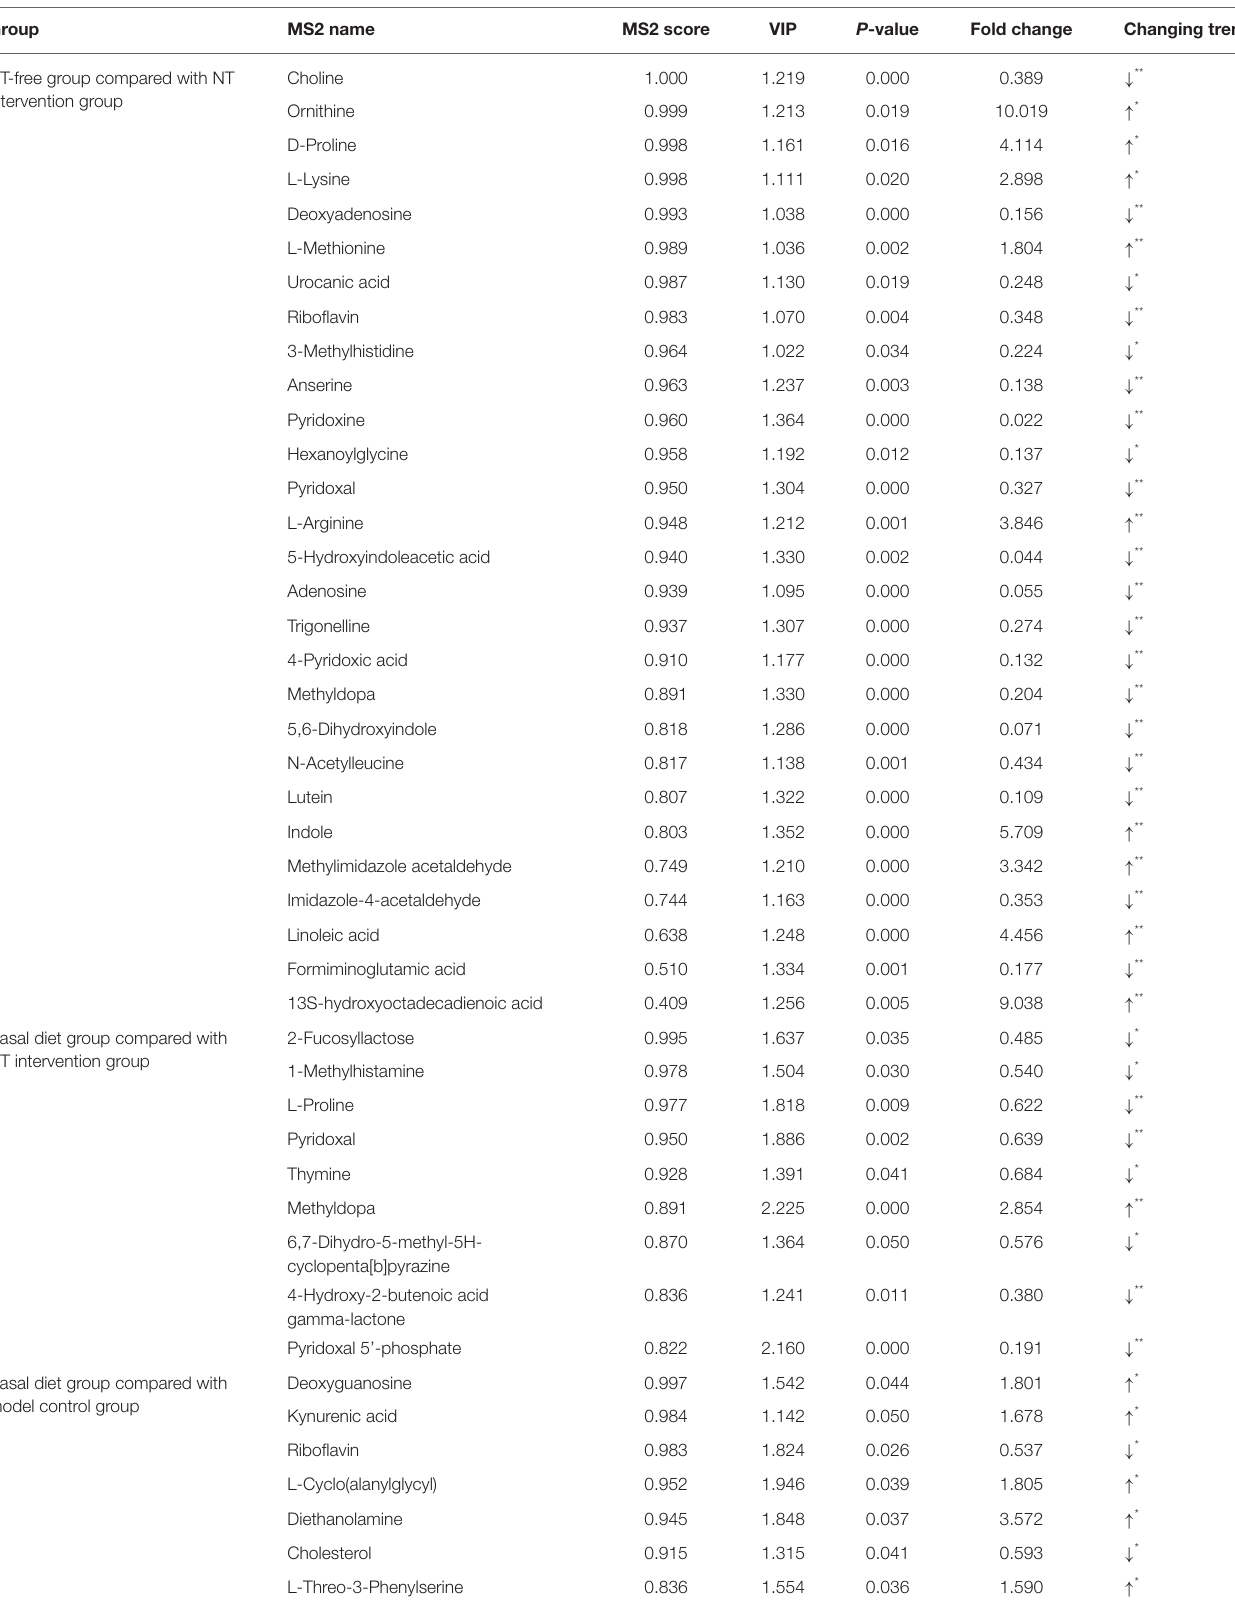
TABLE 1 | Different expressed metabolites in feces of each group in positive ion mode. Group Fold change Changing trend NT-free group compared with NT intervention